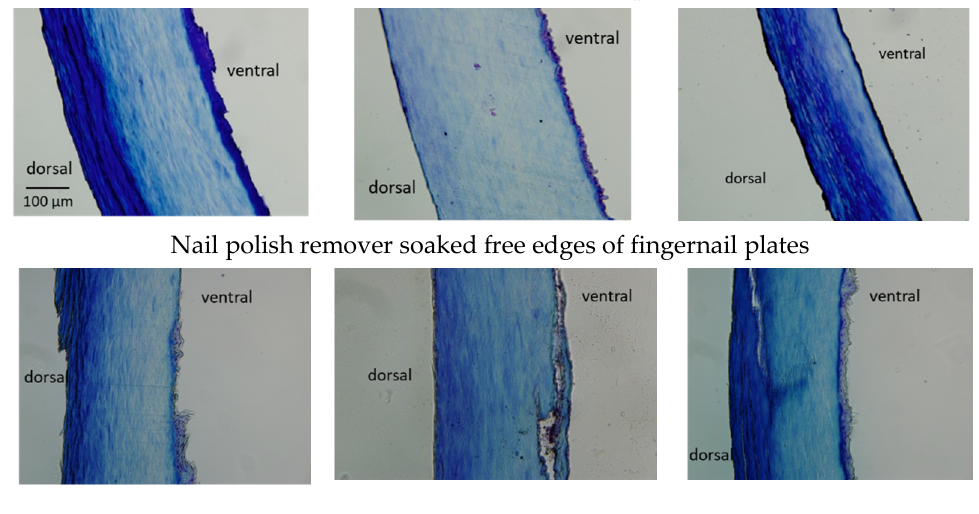
Figure 4. Cross-sectional observations of the normal free edges of the fingernail plates ( left : No. 1, middle : No. 2, right : No. 3) and the nail polish remover soaked free edges of fingernail plates ( left : No. 1, middle : No. 2, right : No.